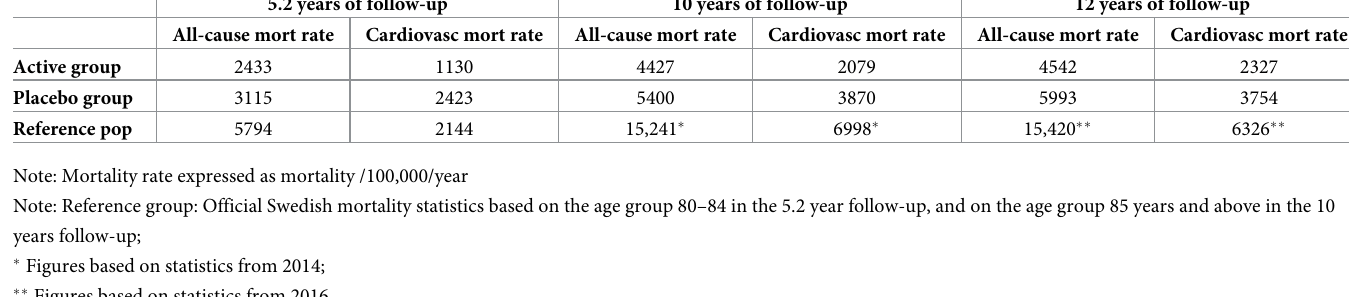
Table 5. Mortality rate after 5 years, 10 years and 12 years in the active treatment group compared to the placebo group, and to official mortality statistics. 5.2 years of